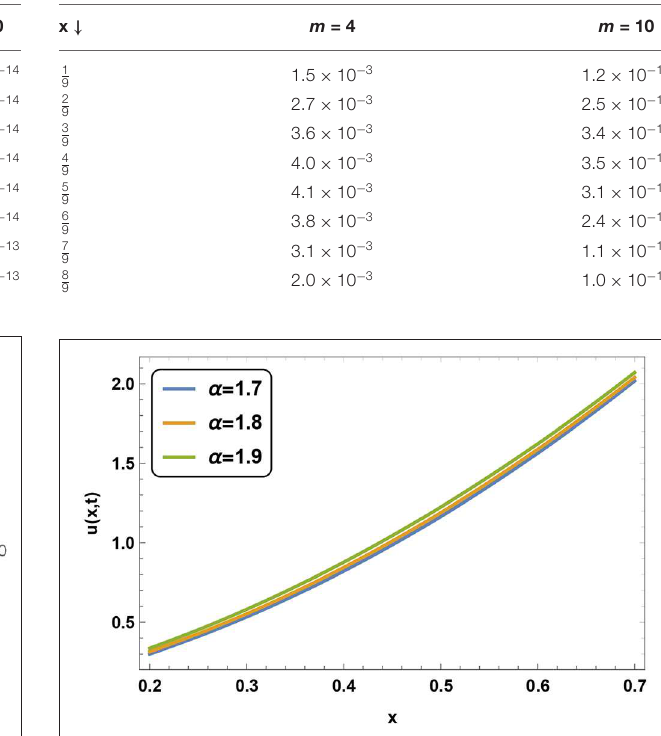
FIGURE 9 | Variation of u with m = 10 and t = 0.1 at different value of α .